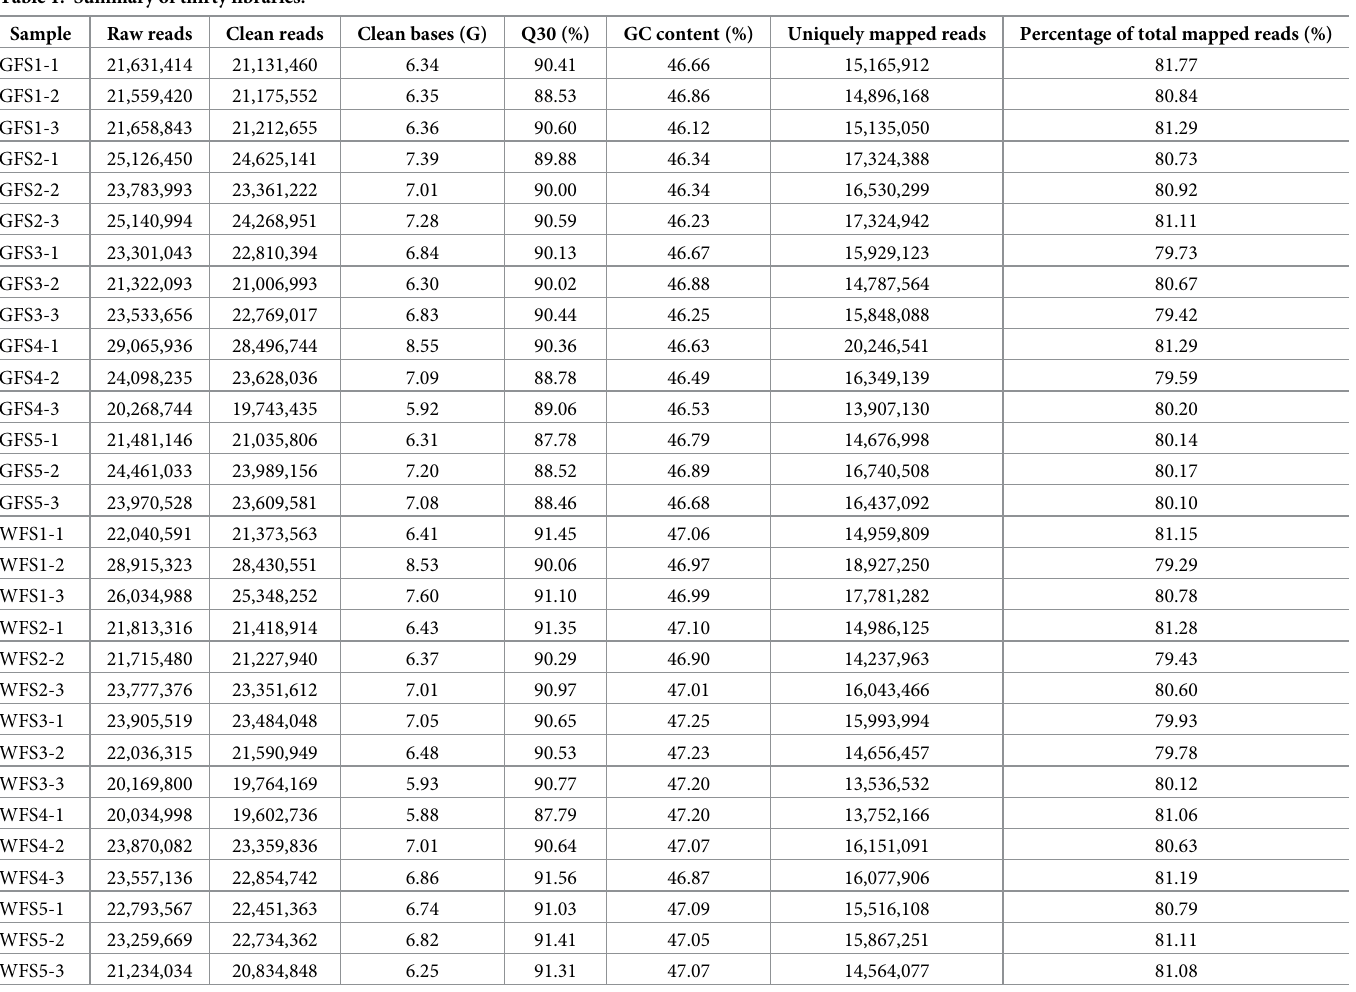
Table 1. Summary of thirty